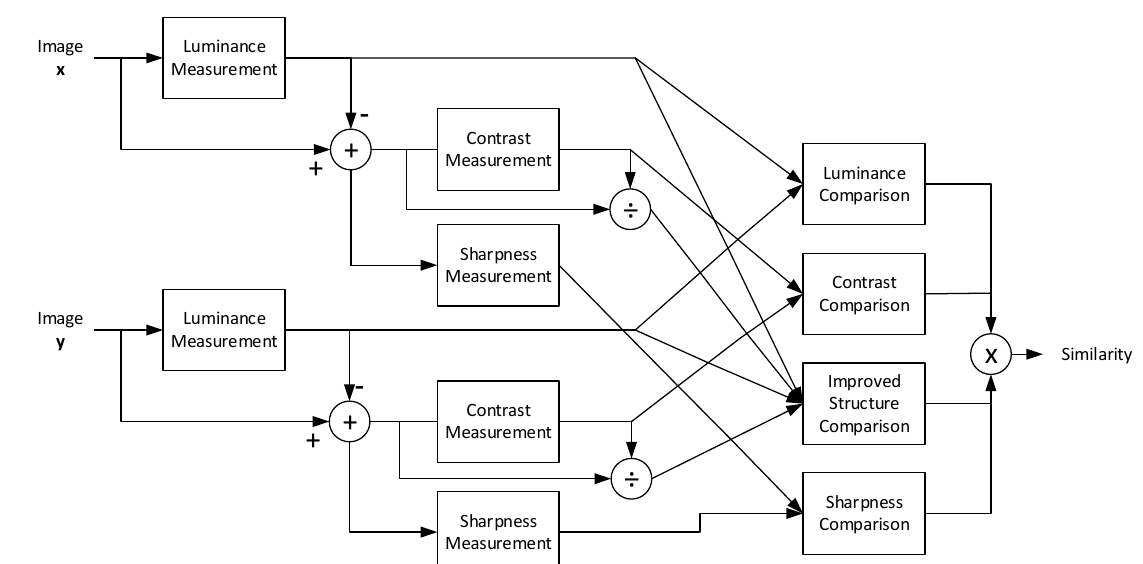
Figure 11. ISSIM-S procedures to quantify the image quality (adapted from [17]).